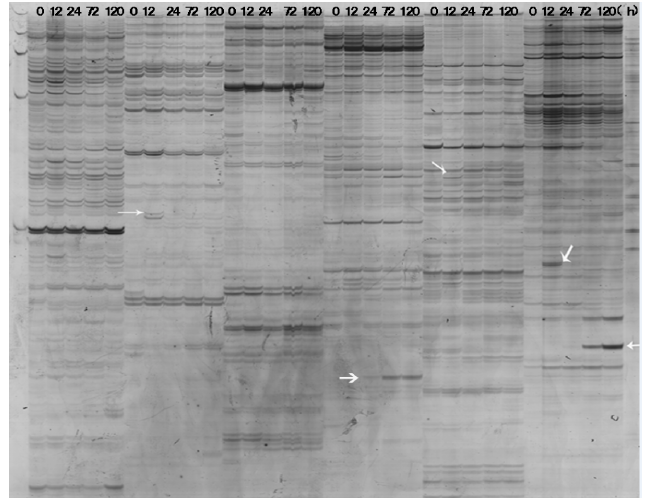
Figure 2. Polyacrylamide gel electrophoresis of partial differentially expressed DNAs (indicated by arrows) amplified by DDRT-PCR from the total RNA samples of RRIC52. Each lane indicates sample from 0, 12, 24, 72, or 120 hpi. Primer sets for each sample group from left to right are H-T11 A and H-AP27, H-T11 A and H-AP28, H-T11 A and H-AP29, H-T11 A and H-AP30, H-T11 A and H-AP30, and H-T11 A and H-AP30.